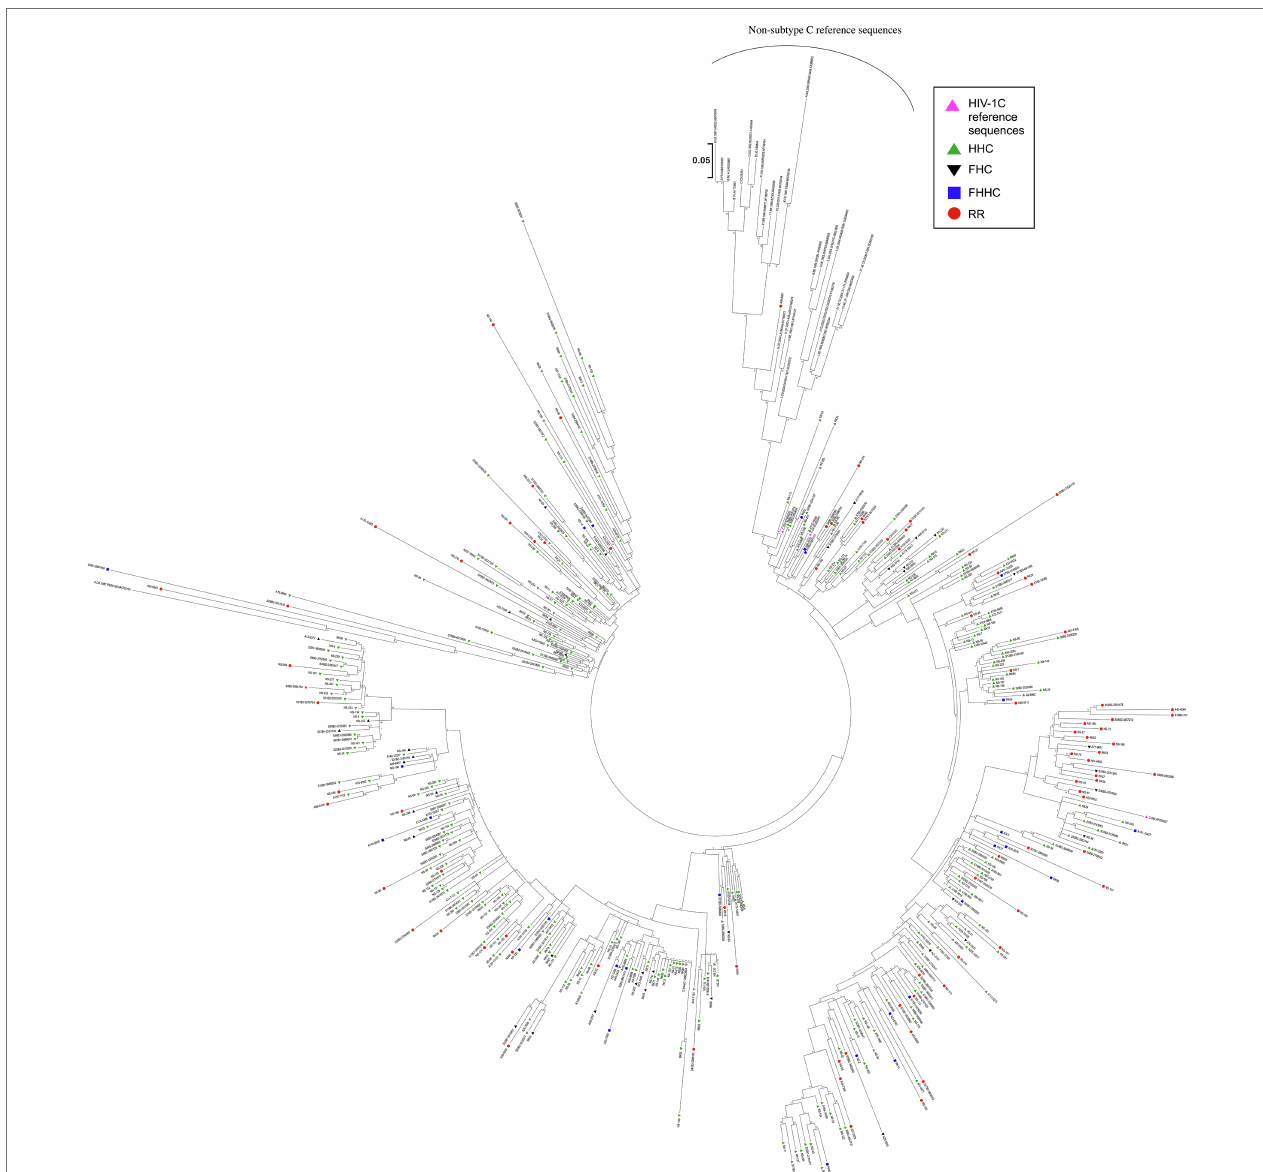
FIGURE 3 | Phylogenetic analysis of HIV-1C LTR variant sequences. A total of 455 viral sequences isolated from study participants are included in the analysis. The analysis also includes four HIV-1C reference sequences and three sequences representing each primary genetic subtype of HIV-1, as described in materials and methods. Different LTR variants are represented using different symbols and colors, as depicted. The evolutionary history was inferred by using the maximum likelihood method based on the Tamura-Nei model. The analysis was performed with 1,000 bootstrap values. The tree is drawn to scale, with branch lengths measured in the number of substitutions per site. There were a total of 292 positions in the final data set. Evolutionary analyses were performed using MEGA 7.0